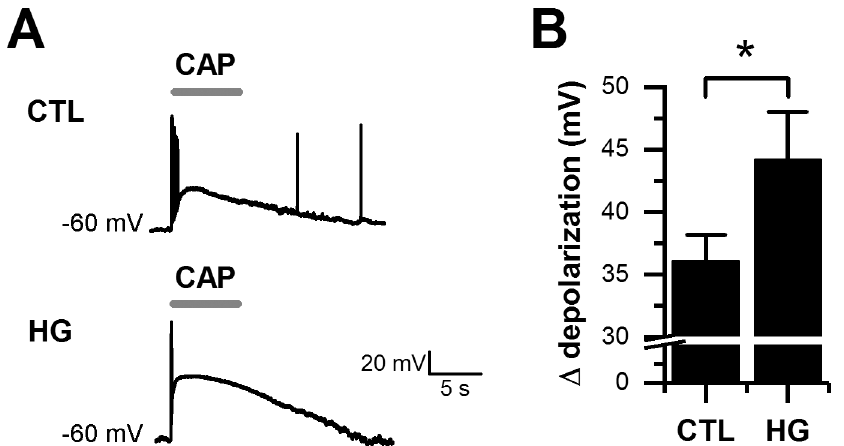
Fig 2. High glucose enhanced CAP-evoked depolarizations in cultured DRG neurons. A, representative traces showing membrane depolarization induced in a single neuron from control (CTL, top trace) or high glucose (HG, bottom trace) condition by 5 s applications of CAP during whole-cell current clamp recordings. B, the bar graph summarizes the change in membrane potential evoked by the application of CAP. All data are represented as mean ± SEM, n = 8 for each condition. Statistical analysis by unpaired t -test; (cid:3) , p < 0.05.